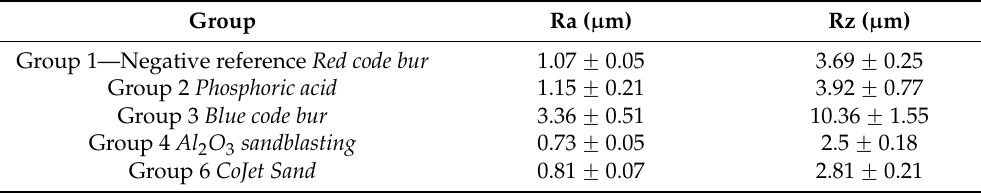
Table 2. Average surface roughness (Ra) and mean roughness depth (Rz) for the different surface